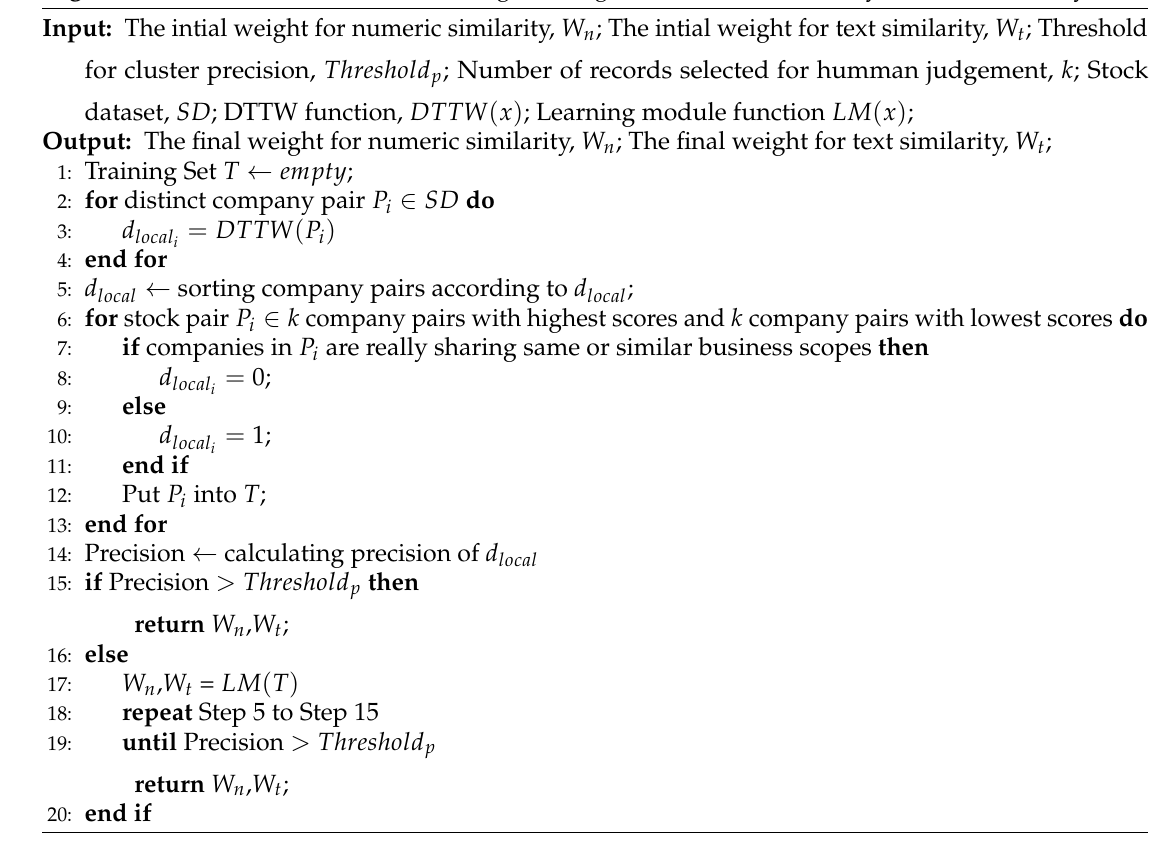
Algorithm 1 Framework of active learning for weights of numeric similarity and text